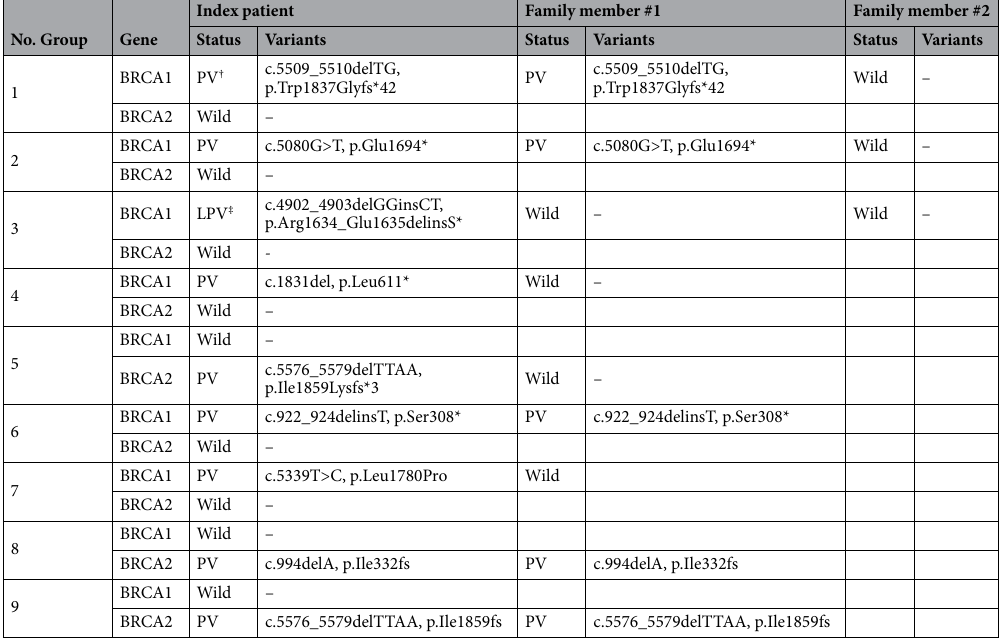
Table 3. Results of targeted cascade genetic testing for gBRCA1/2 status. † PV pathogenic variant, ‡ LPV likely pathogenic